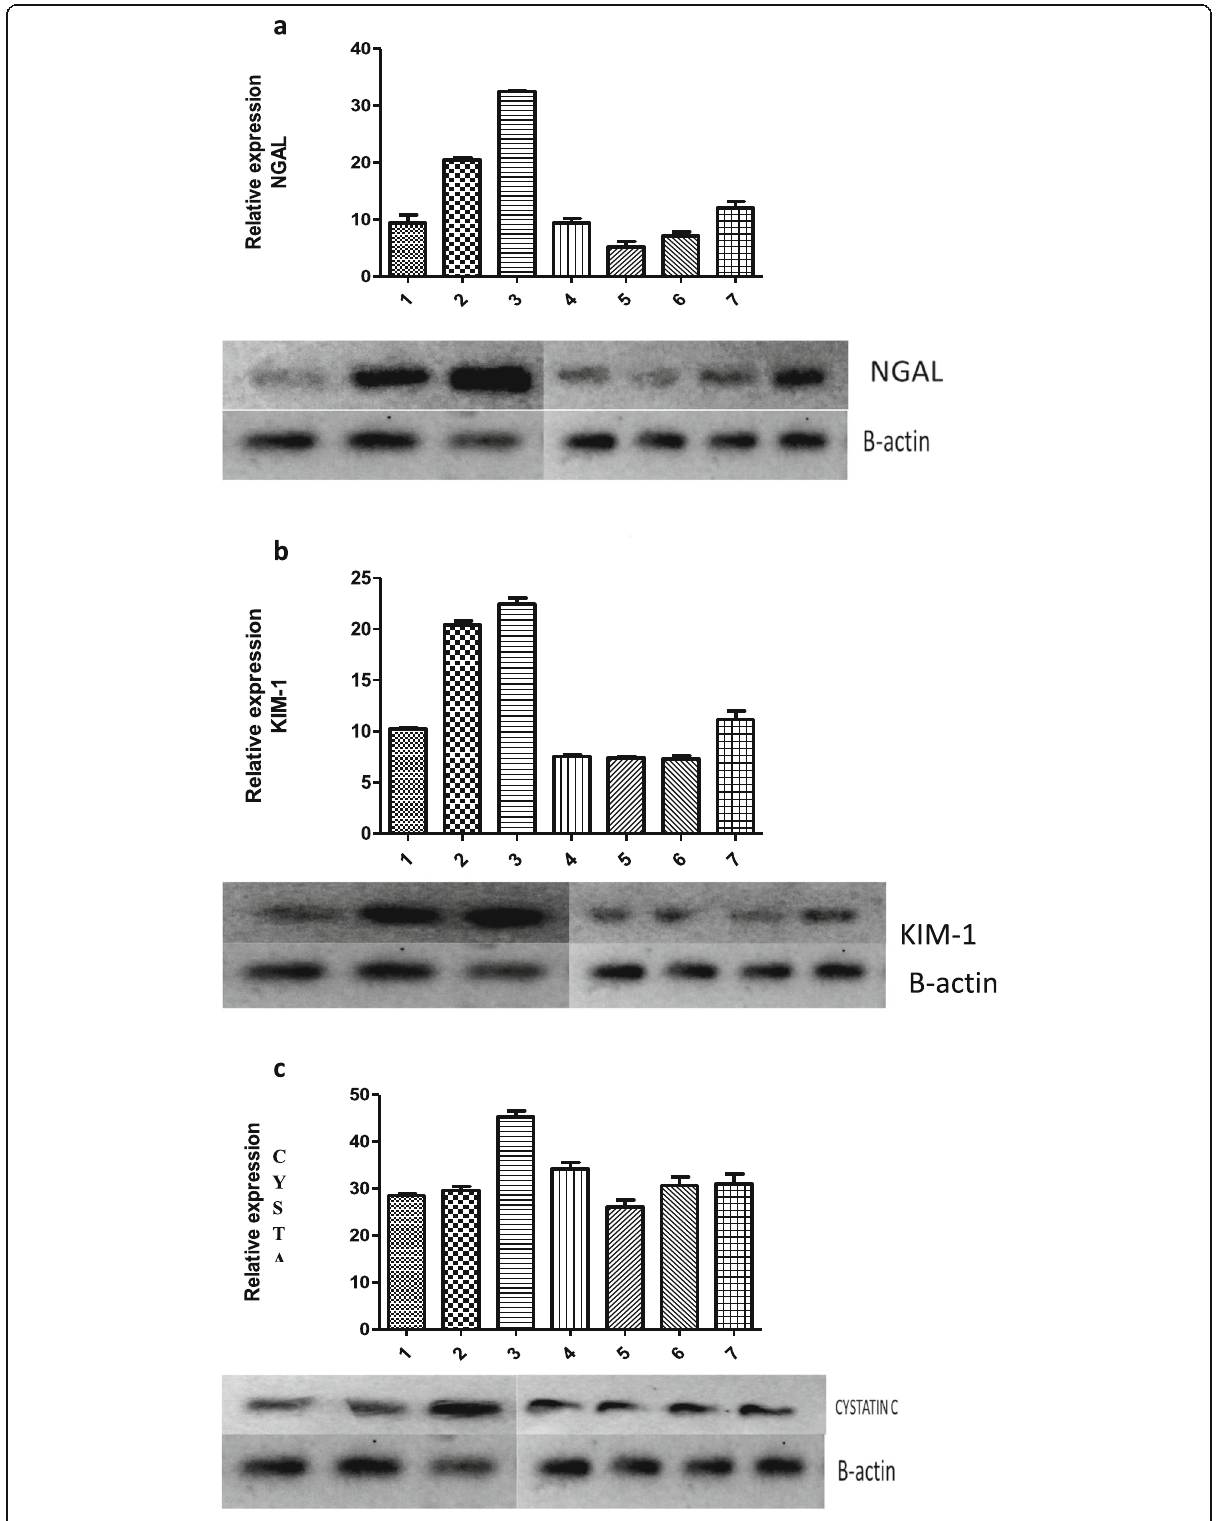
Fig. 5 (See legend on next